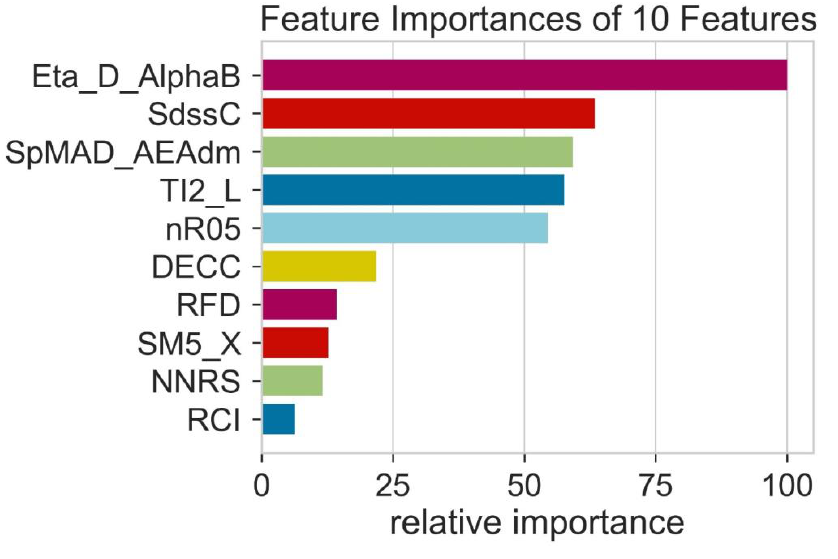
Figure 4. The relative importance of features.